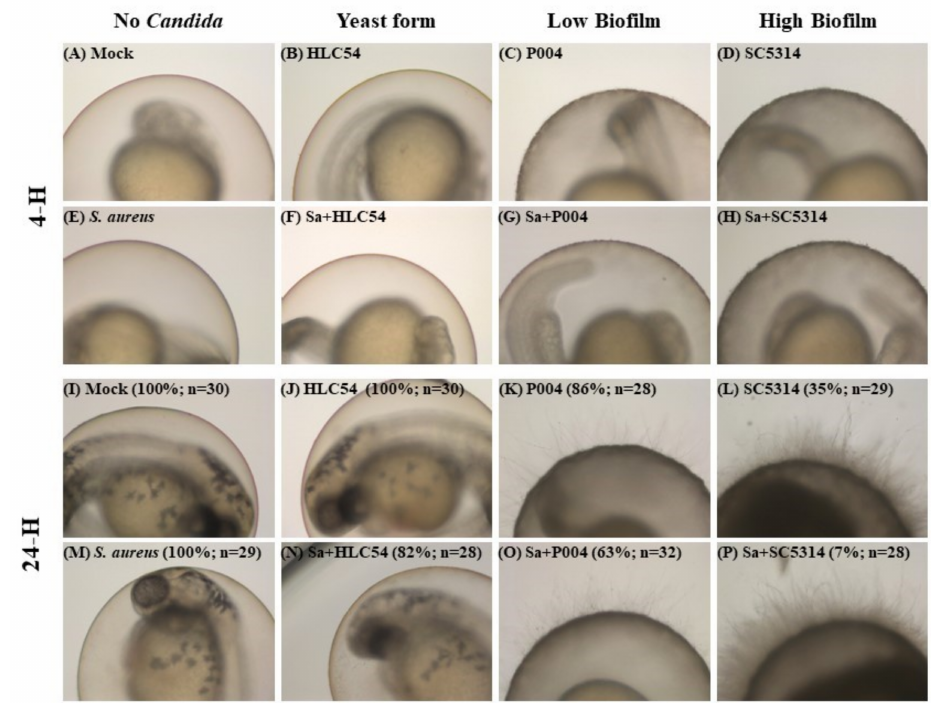
Figure 2. Analysis of in vivo microbial biofilms on zebrafish chorions with C. albicans and S. aureus . After 4-h adhesion, bound microorganisms, including S. aureus ATCC 29213, C. albicans hyphae- defective mutant HLC54, low biofilm clinical strain P004, and wild-type SC5314 strains, were cultivated at 30 ◦ C for 24 h to form mature biofilms ( A – P ). Photographs were taken during the 4-h adhesion and 24-h maturation periods. The survival rate for infected embryos was measured and is shown in parentheses with the number ( n ) of eggs that was used for each experiment. Around 30 embryos were used for each test. The heart-rate of fish embryos was measured to determine the survival rate. Table 4. Protective strength of S. aureus from antibiotic assault due to C. albicans in the co-biofilm.